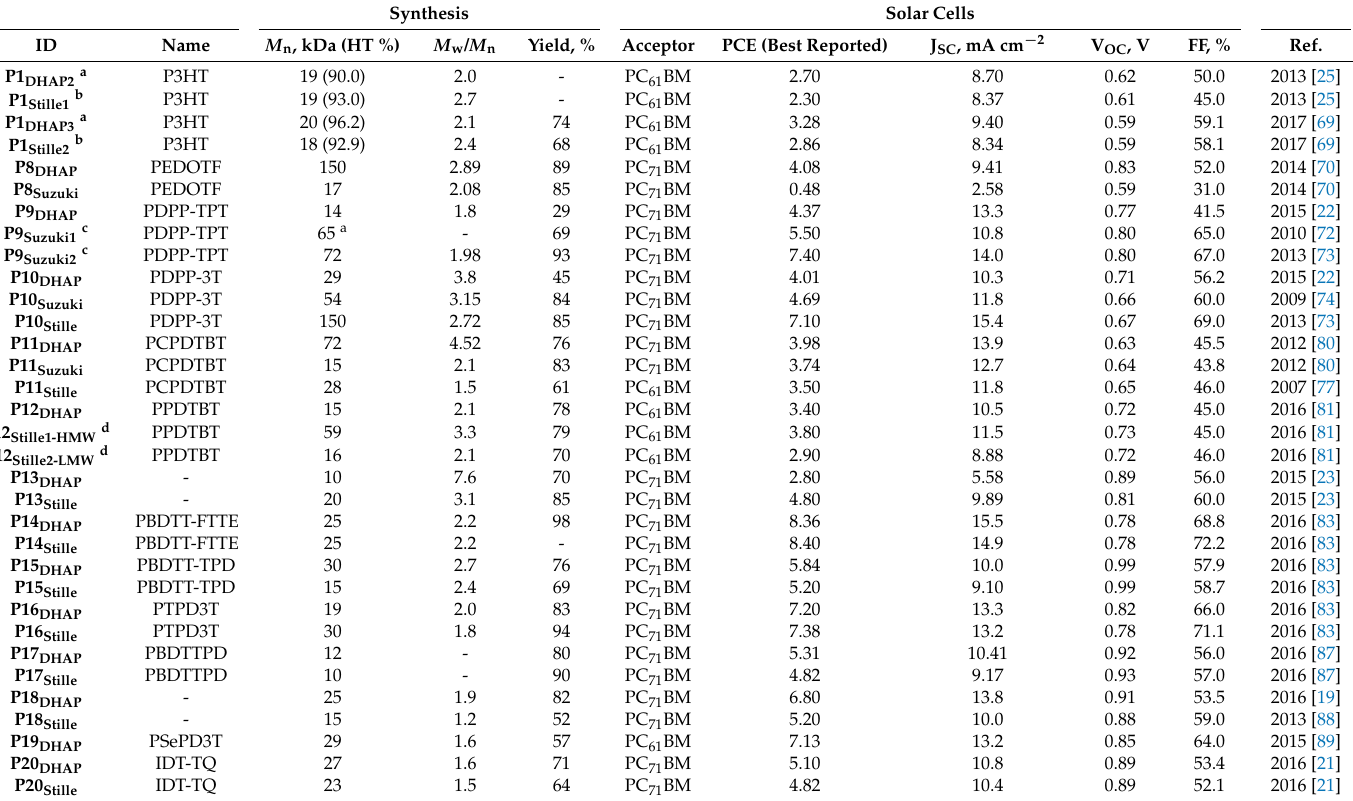
Table 2. Comparison of Polymeric Materials Used in Solar